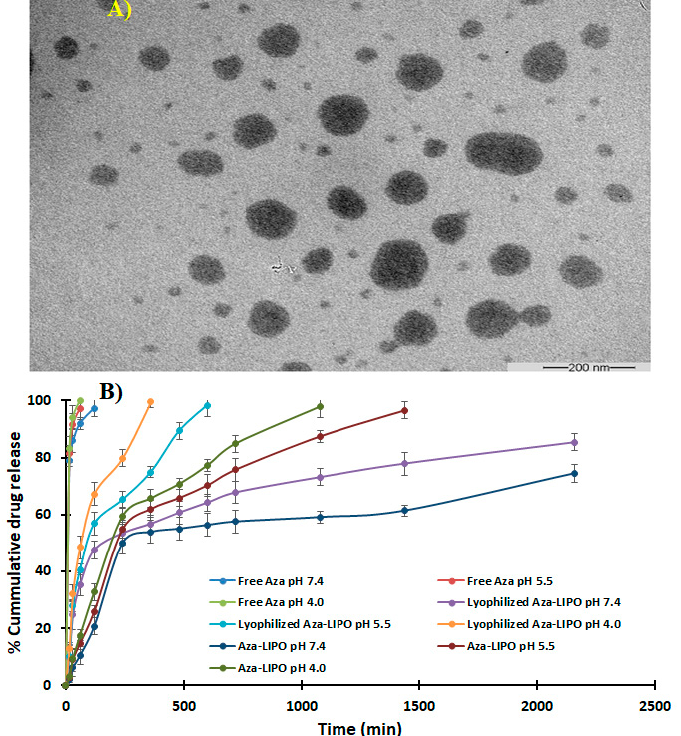
Figure 8. ( A ) TEM image of AZA-LIPO formulation; ( B ) in vitro drug release profile of developed formulations (n = 6).